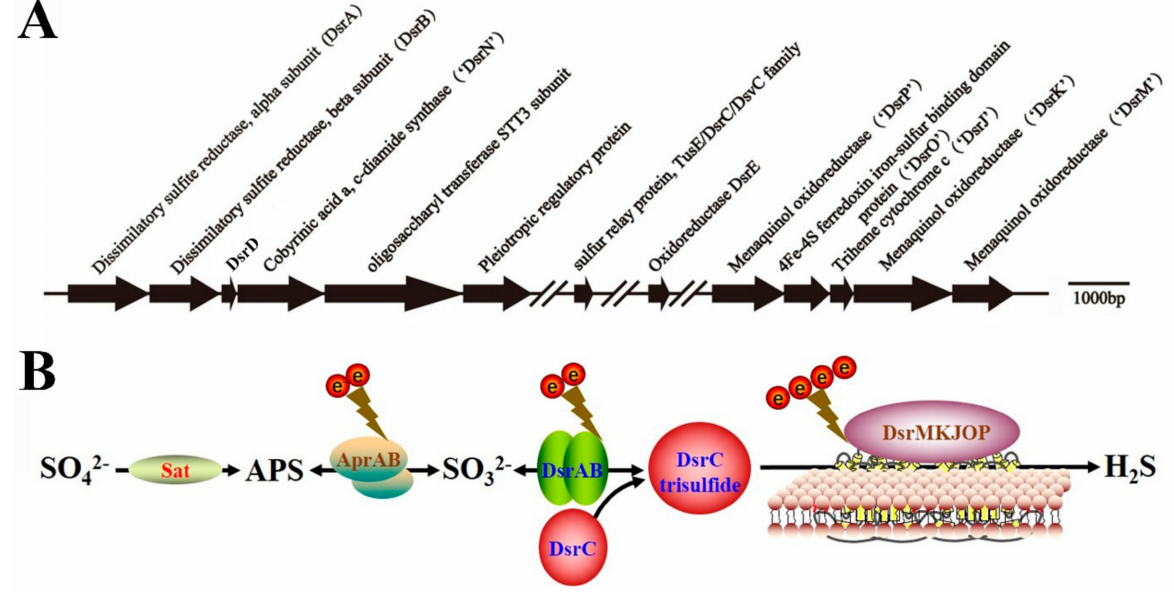
Figure 2. Genomic analysis of dissimilatory sulfate reduction of P. cashew SRB007. ( A ) The gene cluster containing the typical dissimilatory sulfite reductase operon and associated genes identified in the genome of P. cashew SRB007. ( B ) Proposed pathway of dissimilatory sulfate reduction of P. cashew SRB007. Sat, sulfate adenylyltransferase; APS, adenylyl sulfate; AprAB, adenylylsulfate reductase; DsrABC, reverse-type dissimilatory sulfite reductase; DsrMKJOP, sulfite reduction- associated